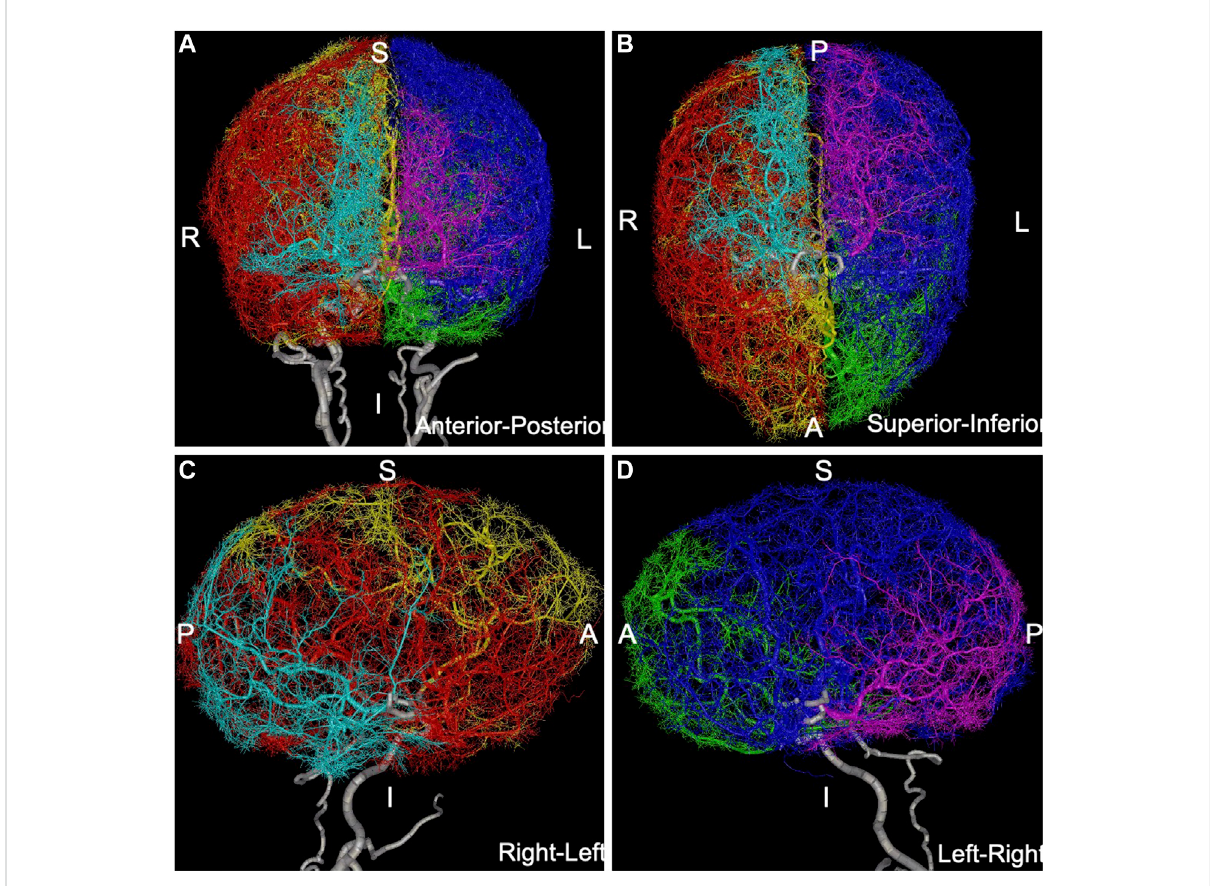
FIGURE 2 Anatomical model containing over 100,000 arterial branches constructed by extending MRA-based model with CCO method: (A) anterior- posterior view, (B) superior-inferior view, (C) right-left view, (D) left-right view. Different arterial trees are rendered with different colors: left-ACA = green, left-MCA = blue, left-PCA = magenta, right-ACA = yellow, right-MCA = red, right-PCA = cyan, main feeding vessels and circle of Willis (ICAs, VAs, BA, PCOMs, ACOM) are rendered in